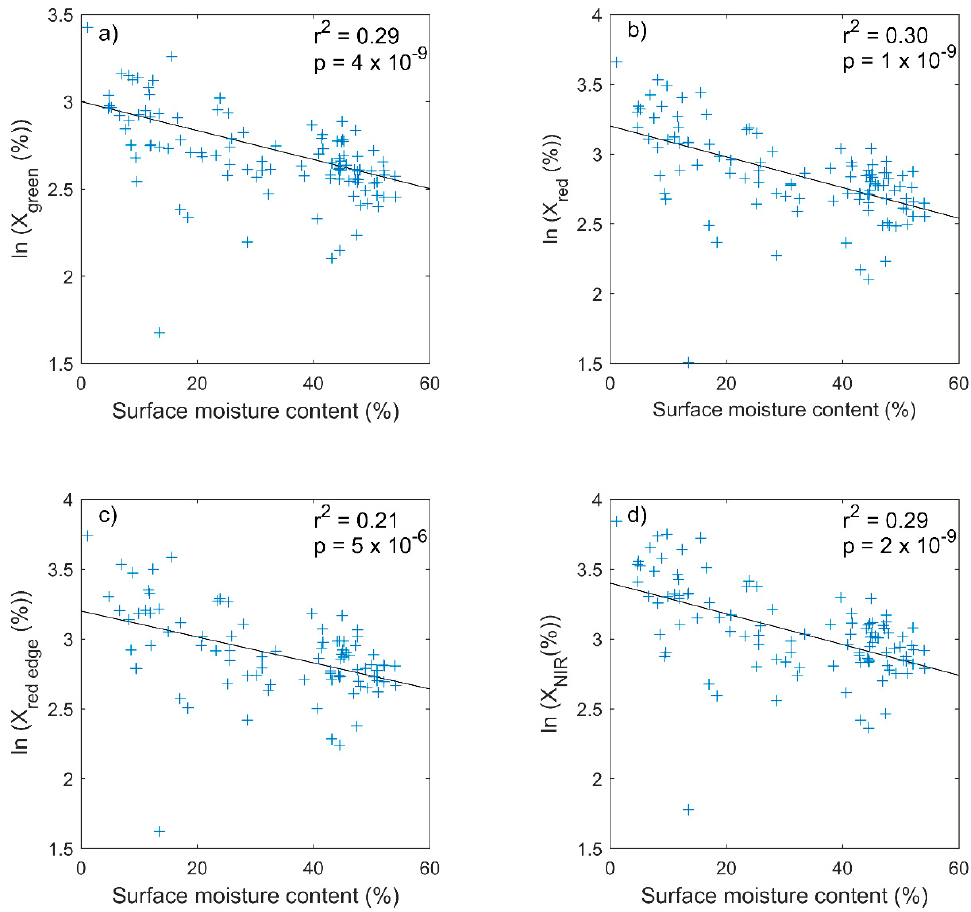
Figure 7. The natural log of reflectance (+) for the multispectral channels against soil moisture from flights at the Neath estuary site, with the line of best fit indicated: ( a ) green reflectance; ( b ) red reflectance; ( c ) red edge reflectance; ( d ) near-infrared reflectance. r 2 and p values for the correlations are given in the top right-hand corner of each graph.